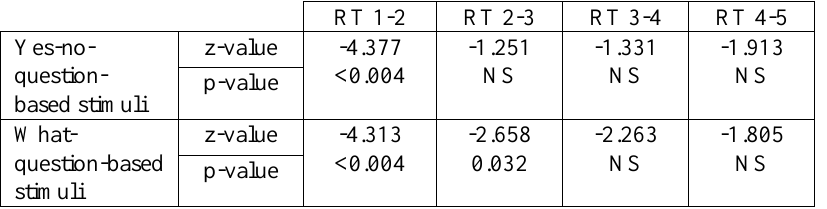
Table V. z- and p-values of four Wilcoxon matched pairs signed rank tests comparing mean RTs between adjacent stimuli for yes-no- -question- and what-question-based